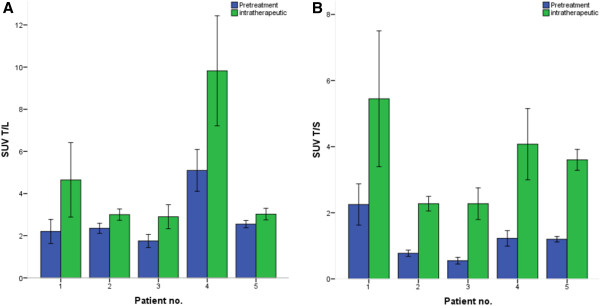
SUV ratios of target lesions to normal tissue in pre- and intra-therapeutic settings using 68Ga-DOTATOC PET. The images show the comparison of the mean tumor-to-liver (A) and tumor-to-spleen (B) SUV ratios in each patient (n = 5).